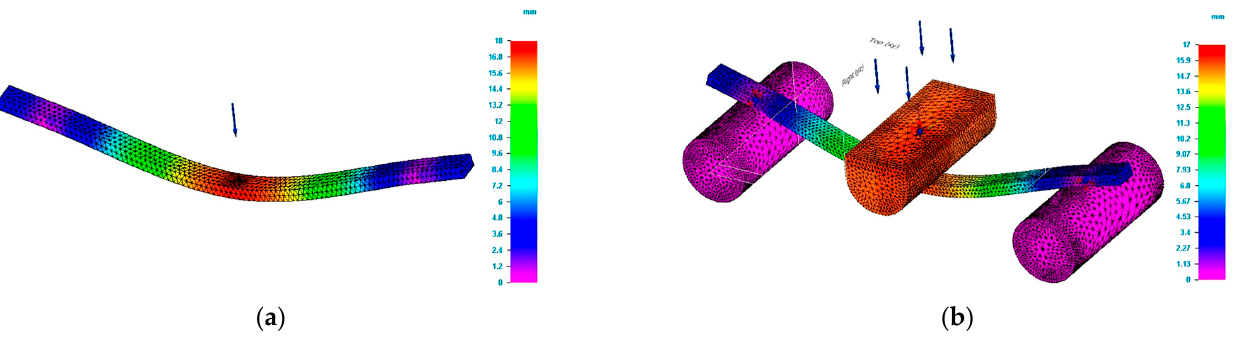
Figure 6. Result of simulation process for G_R5 specimen (total deformation values). ( a ) Total deformation values for simple modelling. ( b ) Total deformation values for complex modelling.